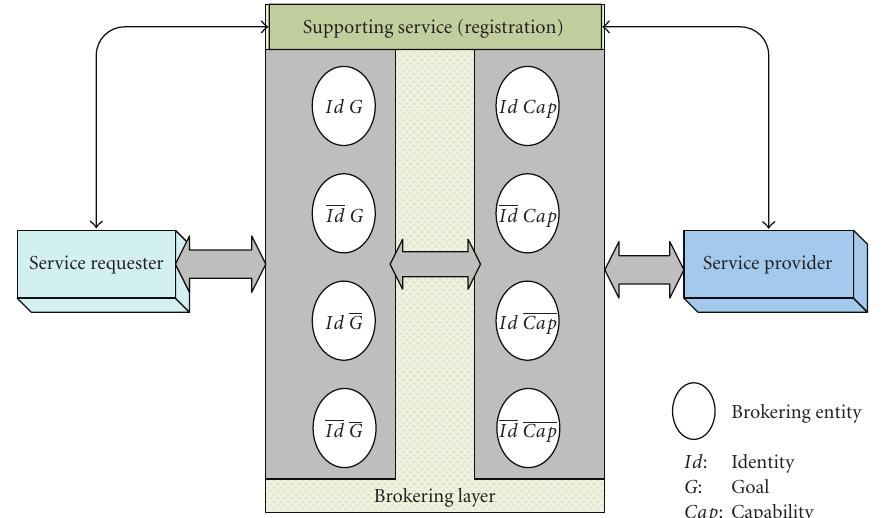
Figure 1: Logical view of the brokering service.